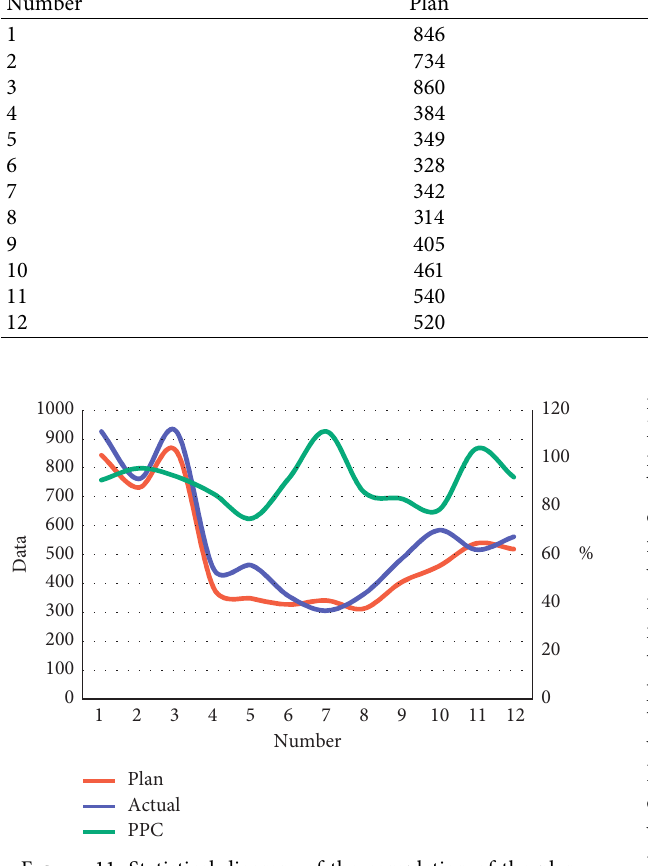
Figure 11: Statistical diagram of the completion of the